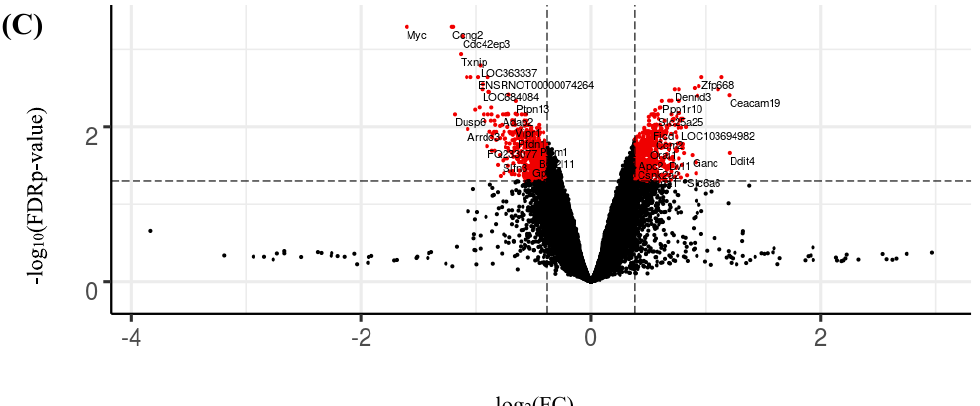
Figure 3. Volcano plots displaying differentially expressed genes between NM-105 treated and control samples for ( A ) in vitro submerged, ( B ) in vivo lung and ( C ) in vitro ALI exposures. Vertical axis corresponds to the -log 10 (FDR corrected p -value) and the horizontal axis displays the log2-fold change value. The vertical lines correspond to 1.3-fold up and down changes (log 2 FC = 0.38), respectively, and the horizontal line represents FDR corrected p -value of 0.05 (-log 10 P = 1.3). Red dots represent the up- and downregulated expressed genes.